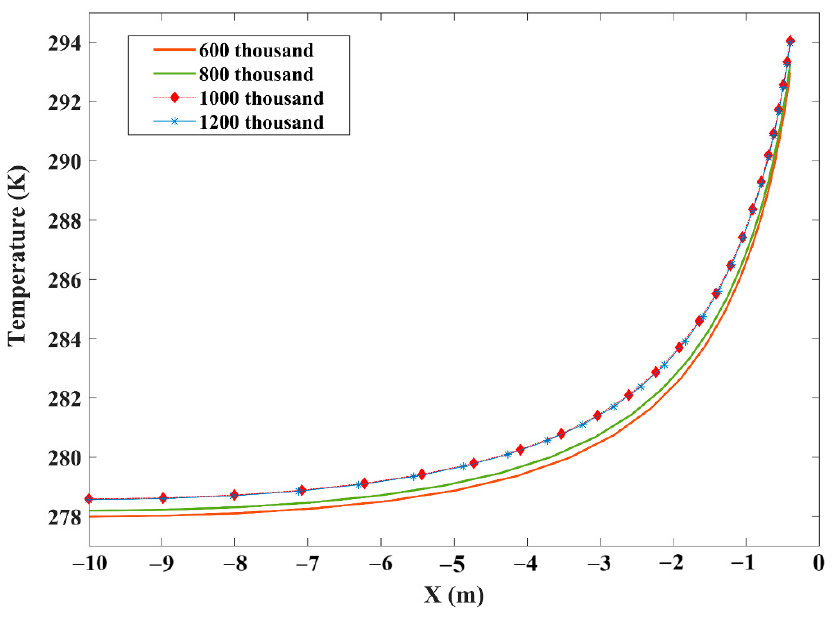
Figure 3. Mesh independence verification.